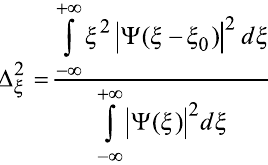
(Figure 4). The Heisenberg box centered at time t and frequen- cy ω = 2 π F is thus defined as